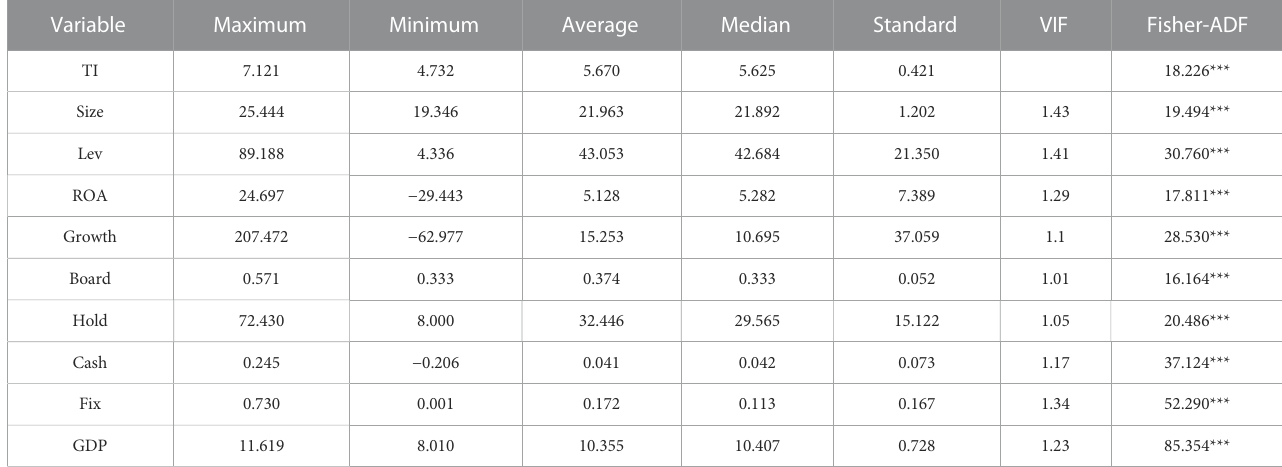
TABLE 3 Descriptive statistical results from 2008 to